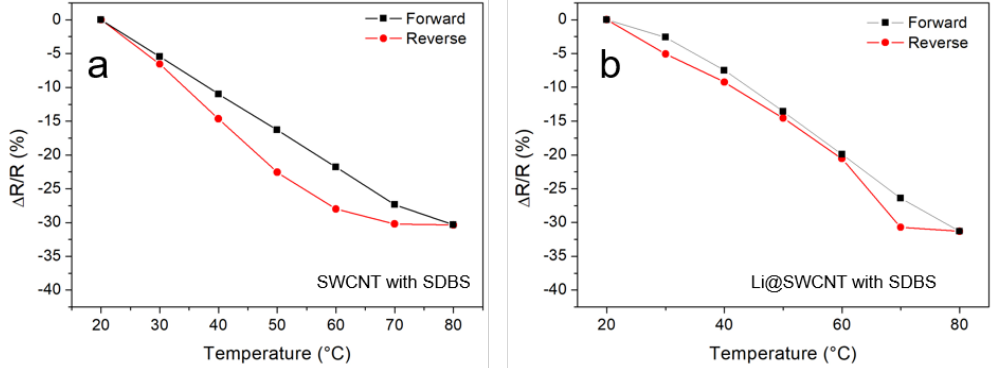
Figure 6. Temperature response of ( a ) of undoped SWCNT/SDBS films and ( b ) of Li@SWCNT/SDBS films. Measurement were performed at constant humidity of ≈